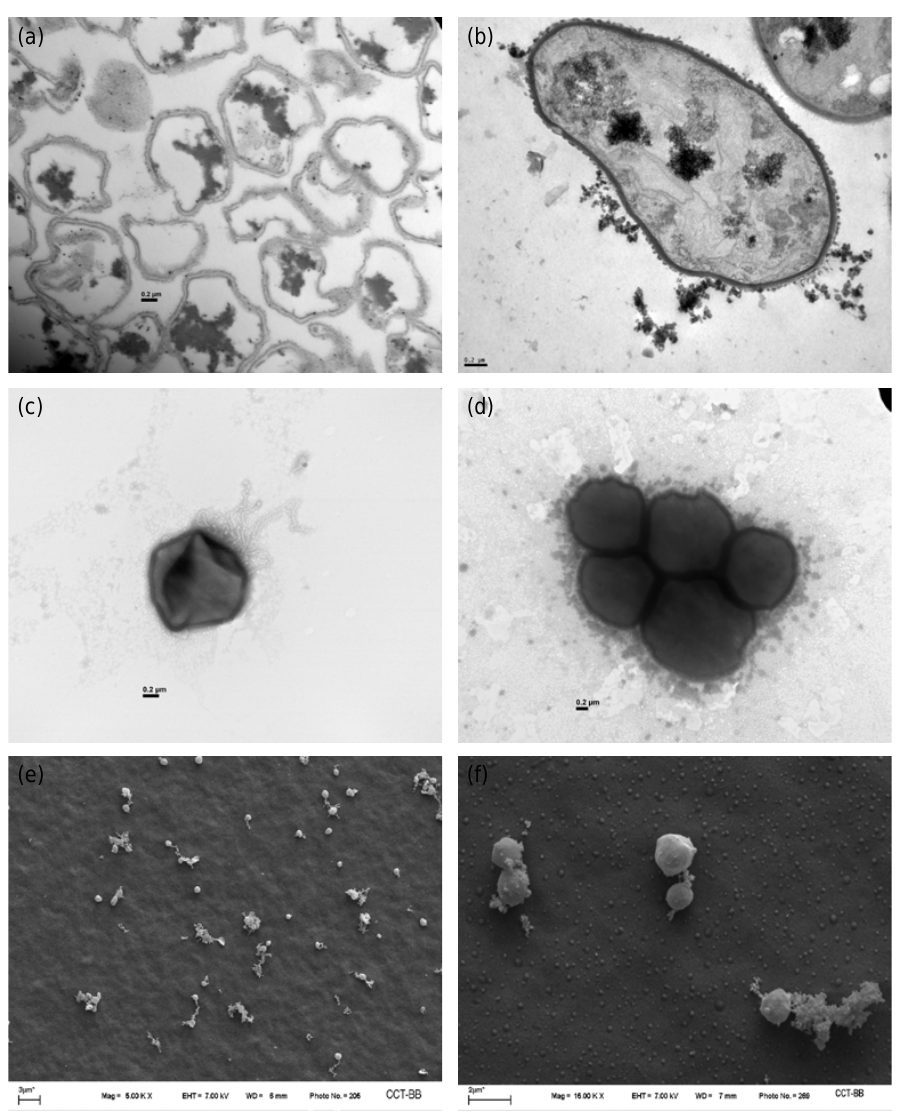
Figure 1. A. copahuensis cells visualized by transmission electron microscopy ( a – d ) and scanning electron microscopy ( e , f ) micrographs. Cells were grown with tetrathionate ( a , e ), sulfur ( b , c ), glucose ( d ), and pyrite ( f ).